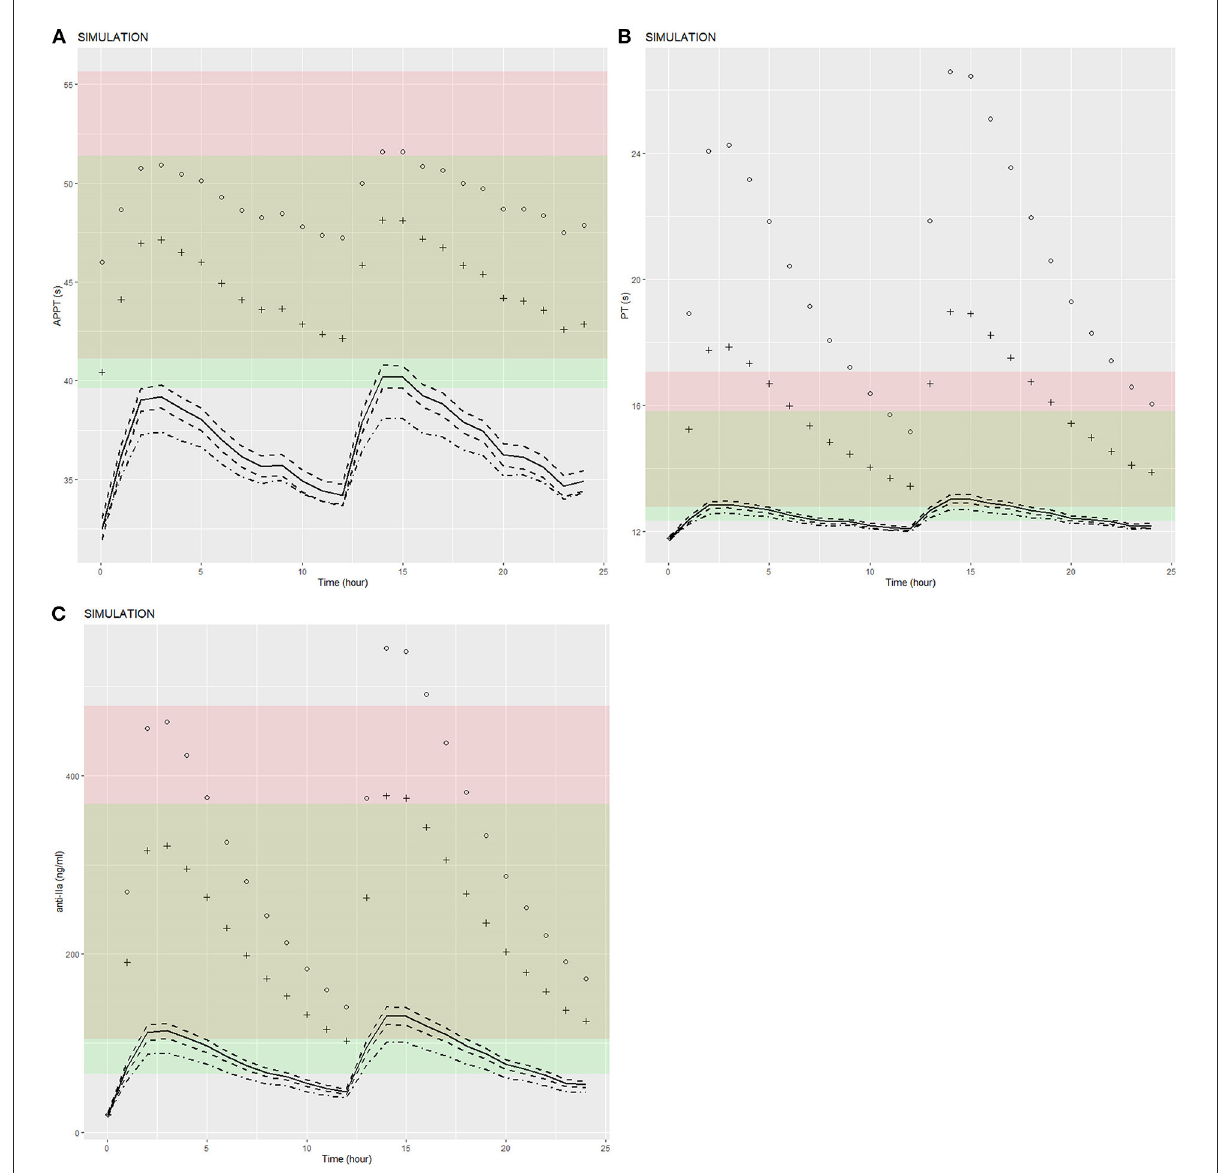
FIGURE5 Predicted APTT, PT, and anti-FIIa PD-time profiles. (A) APTT. (B) PT. (C) Anti-FIIa. Annotation: The black dot represents a patient with mean characteristics (dose = 110mg bid, HDL = 1.4 mmol/L, age = 24 y, CrCL = 30 mL/min). The black cross represents a patient with mean characteristics (dose = 150mg bid, HDL = 1.4 mmol/L, age = 24 y, CrCL = 50 mL/min). The black solid line represents a patient with mean characteristics (dose = 150mg bid, HDL = 1.4 mmol/L, age = 24 y, CrCL = 118.76 mL/min) and the black dotted line 1 represents the corresponding 95% confidence interval. The black dotted line 2 represents the 95% confidence interval of a patient with mean characteristics (dose = 110mg bid, HDL = 1.4 mmol/L, age = 24 y, CrCL = 118.76 mL/min). The red shaded area represents the predicted peak concentration ranges of APTT, PT, and anti-FIIa. The green shaded area represents the predicted trough concentration ranges of APTT, PT, and anti-FIIa. The yellow shaded area represents the predicted overlap of the trough and peak concentration ranges of APTT, PT, and